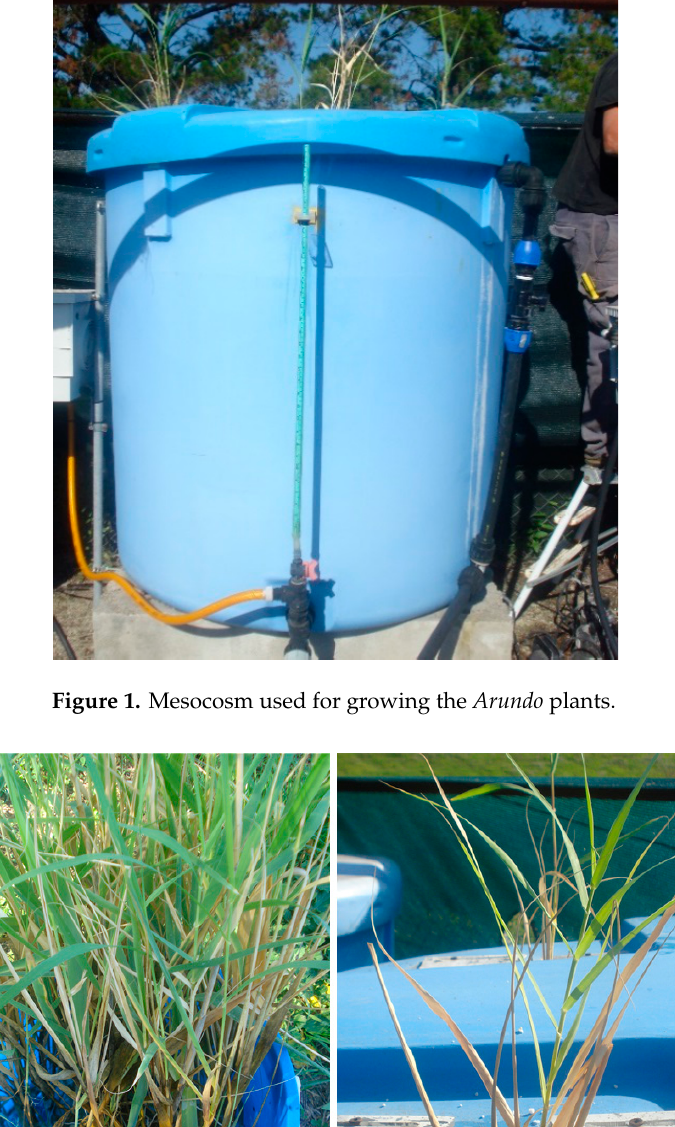
Figure 1. Mesocosm used for growing the Arundo plants.